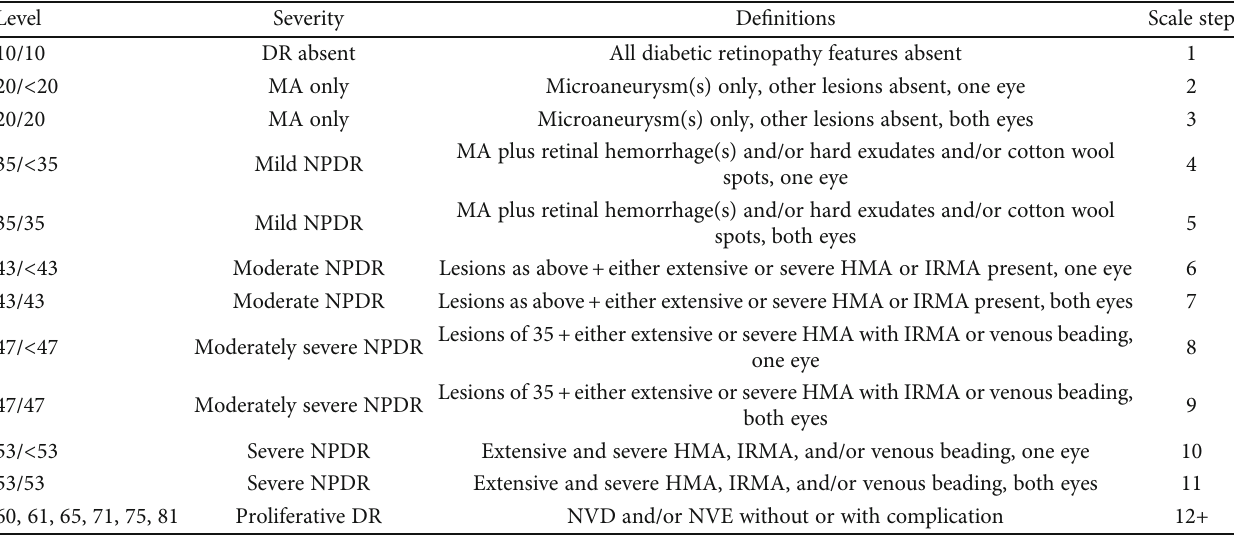
Table 3: The grading system from the Early Treatment of Diabetic Retinopathy Study.